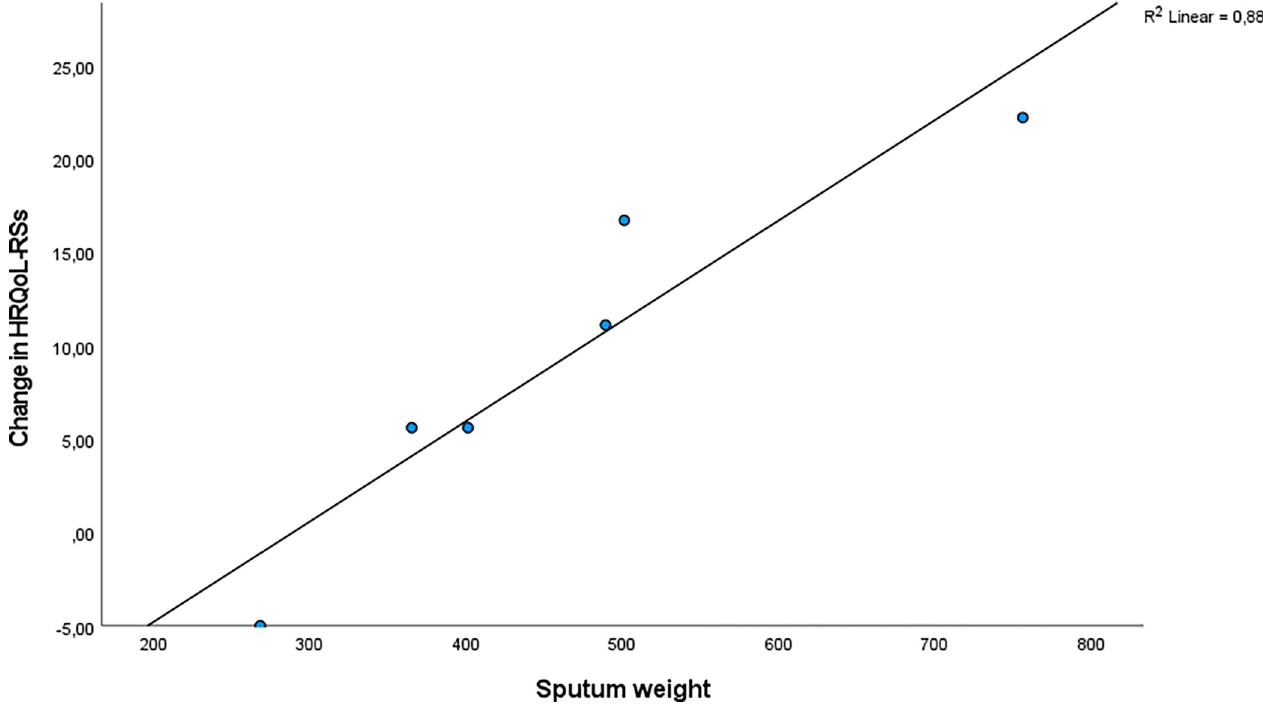
Fig 2. The correlation between total sputum weight (g) produced by the participants during the study (week 1–8) and the change in CFQ-R-RSS.